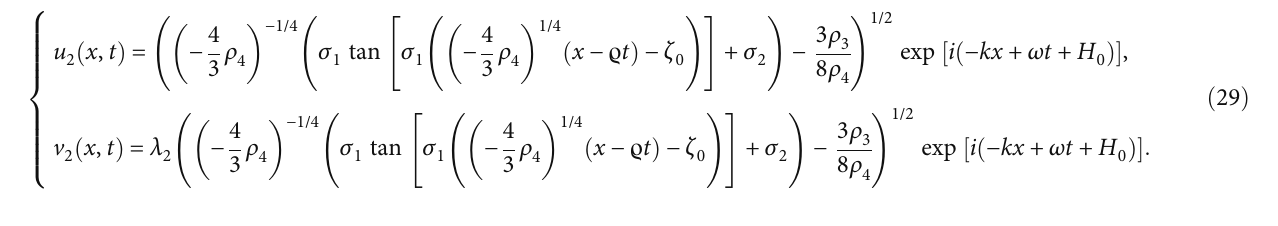
= 1, b = 3, c = 4, d 1 1 1 = γ = δ = − 1, α = 3, and β 2 2 2 2